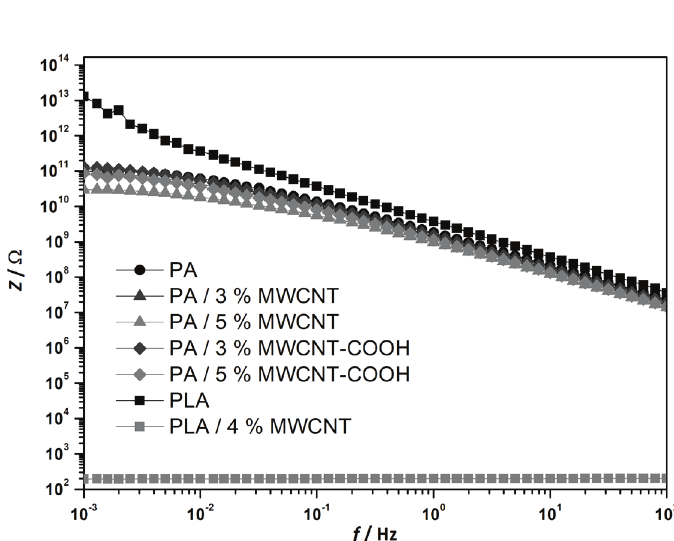
Fig. 10 – Impedance spectrum of an absolute impedance logarithm |Z| of the PA and PLA matrices, and PA/MWCNT and PLA/MWCNT nanocomposites versus the logarithm of the ap- plied frequency